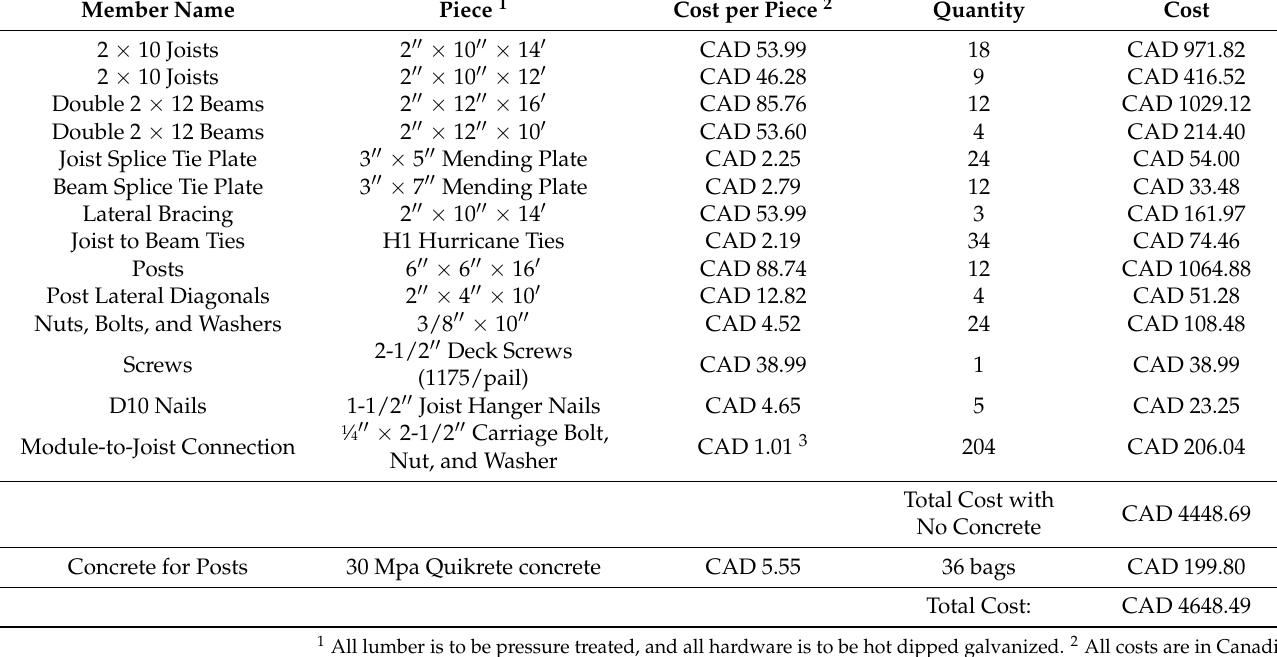
Table 4. Single-span system Bill of